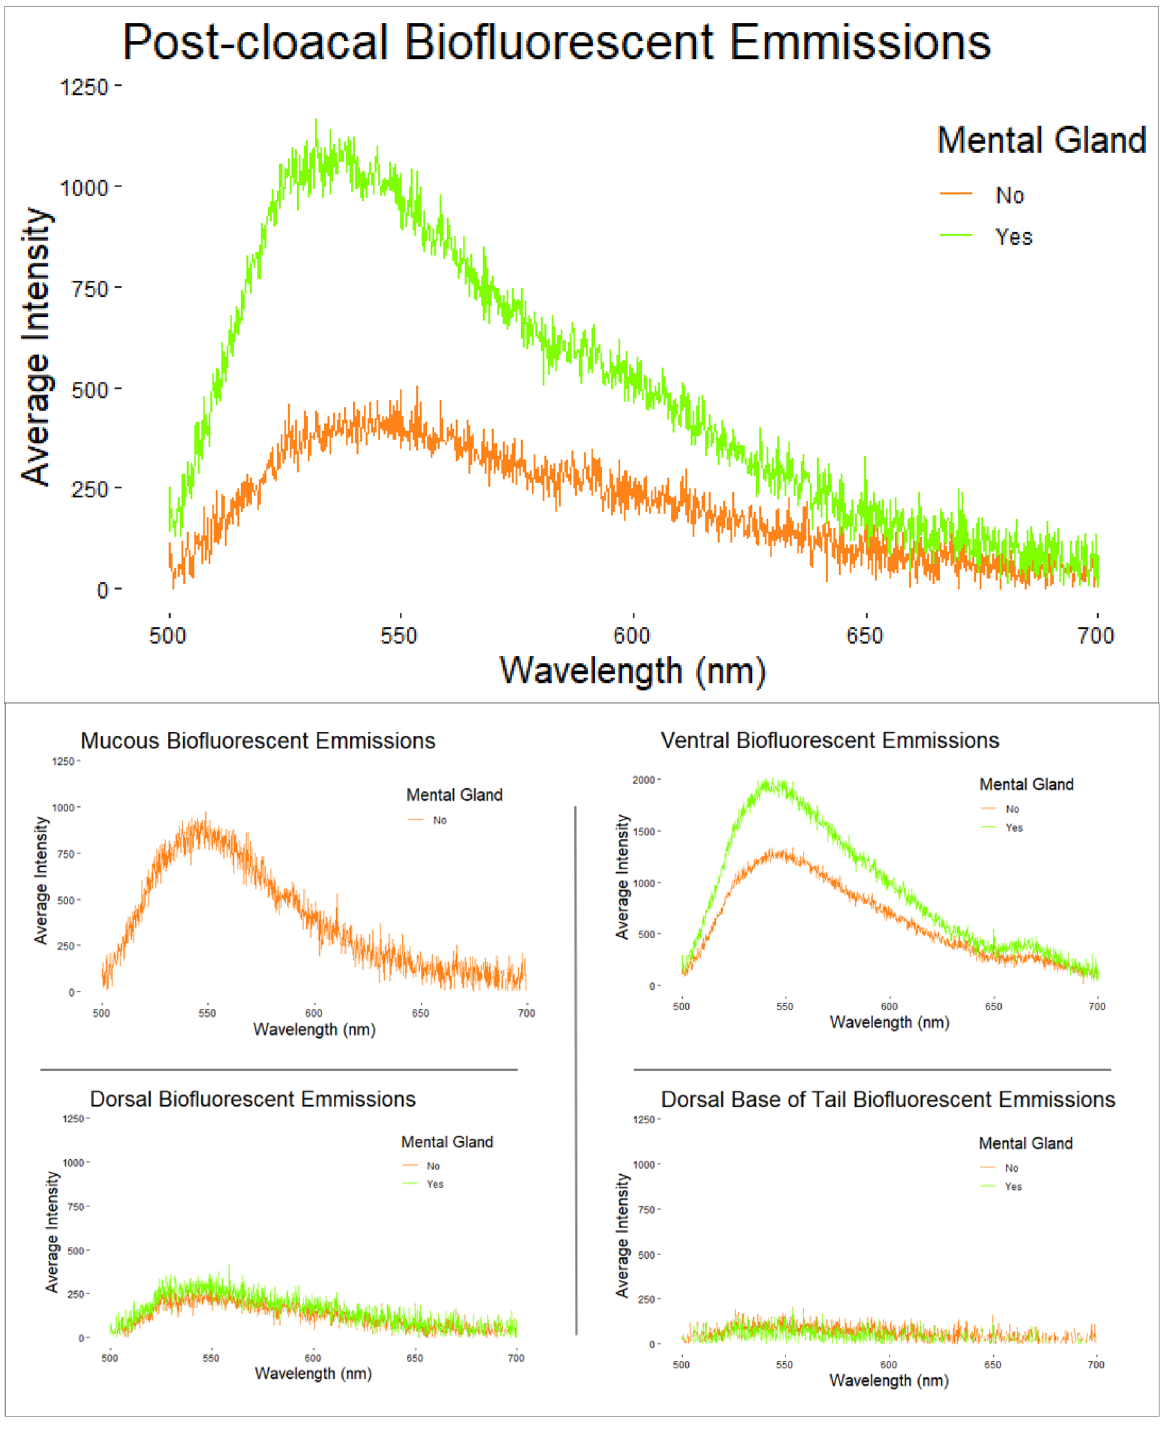
Figure 4. The biofluorescent spectral emissions averaged by male (green; n = 12) and presumed female (orange; n = 19) P. metcalfi salamanders recorded while exposed to blue light and filtered with a 500 nm longpass filter. Each graph represents a different anatomical region or mucous (n = 1)